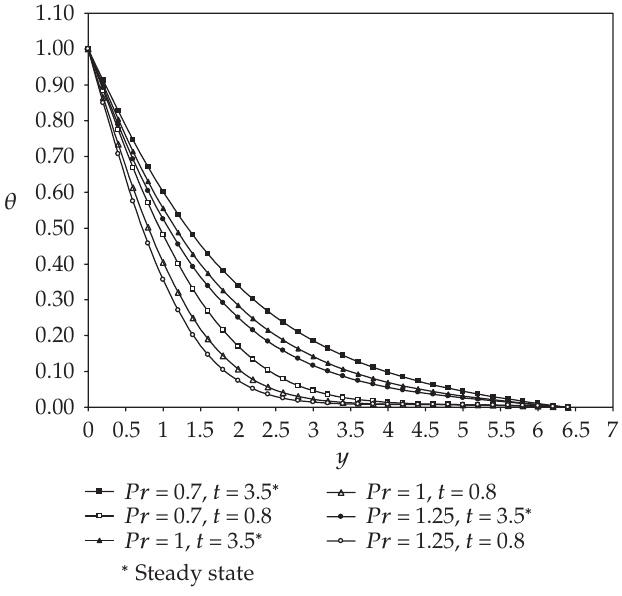
Figure 5.8 . Transient temperature profiles for the di ff erent values of Pr and the values x = 1, F = 0 . 01, m = 1, and M = 1.